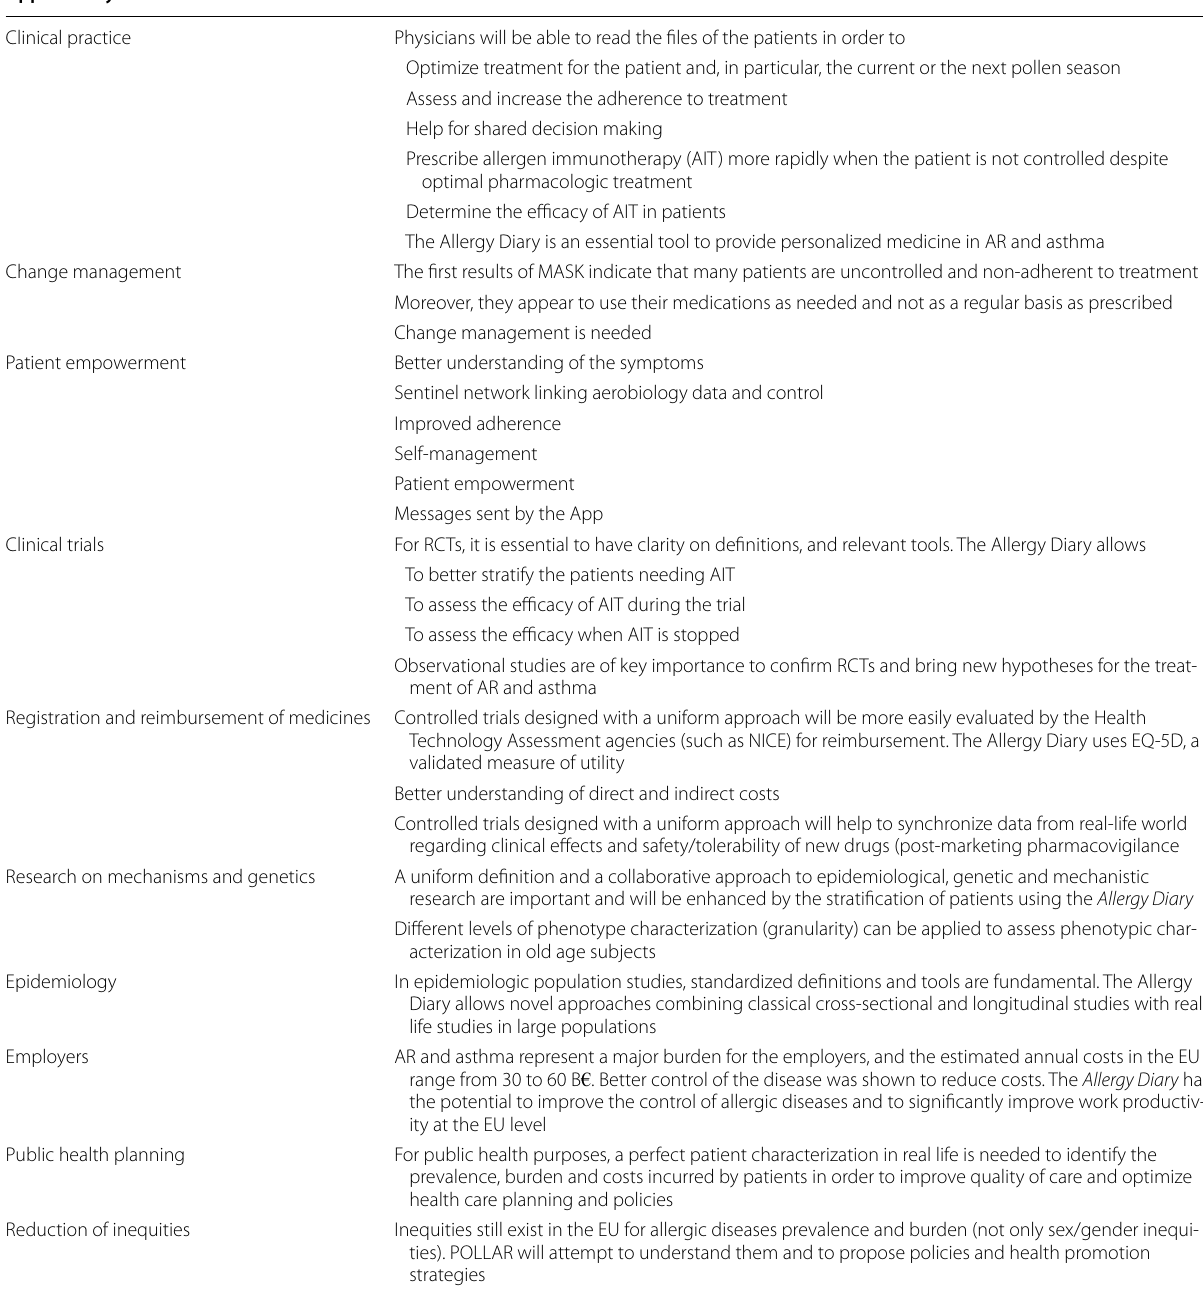
Table 4 Global applicability of MASK